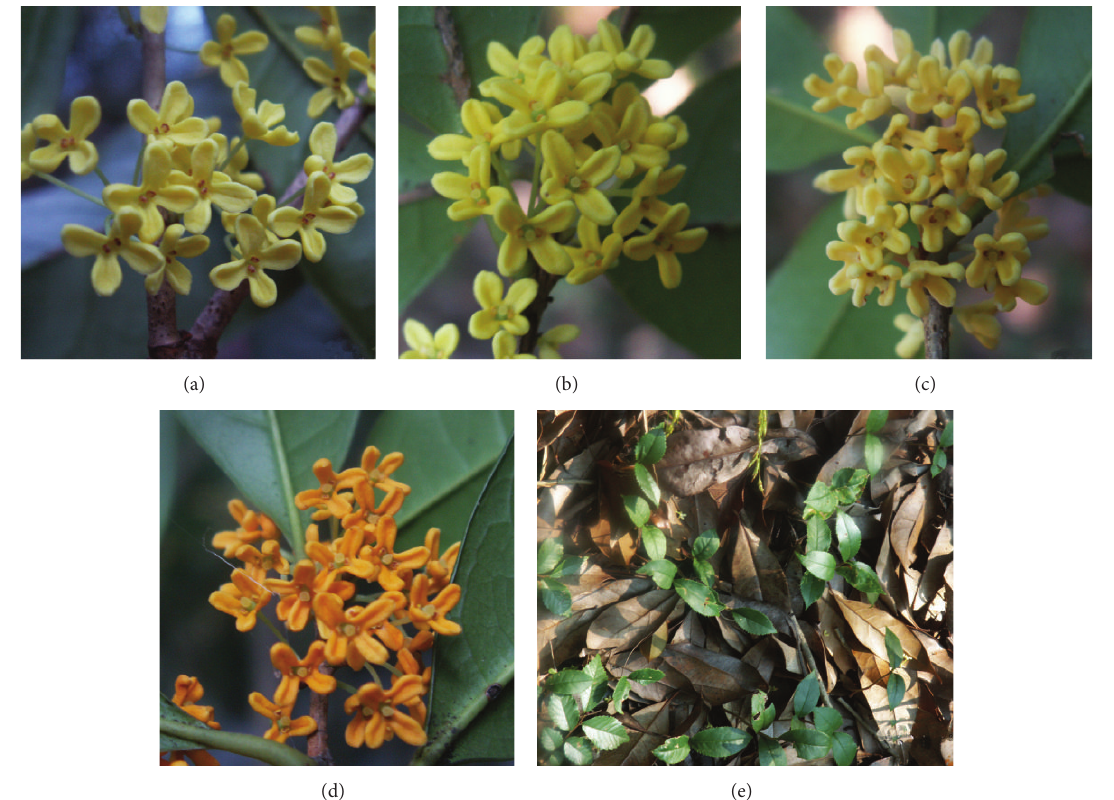
Figure 5: Floral traits of four individuals (a–d) and sexual reproduction (e) in QDH